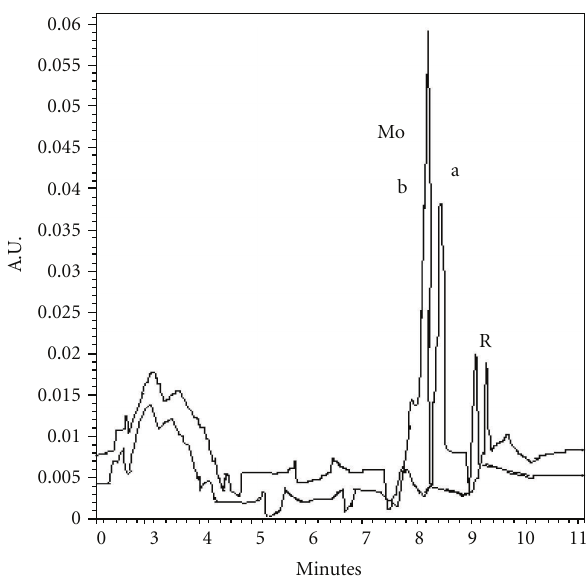
Figure 8: Electropherogram of (a) potato sample (b) spiked with standard Mo solution under standard operating